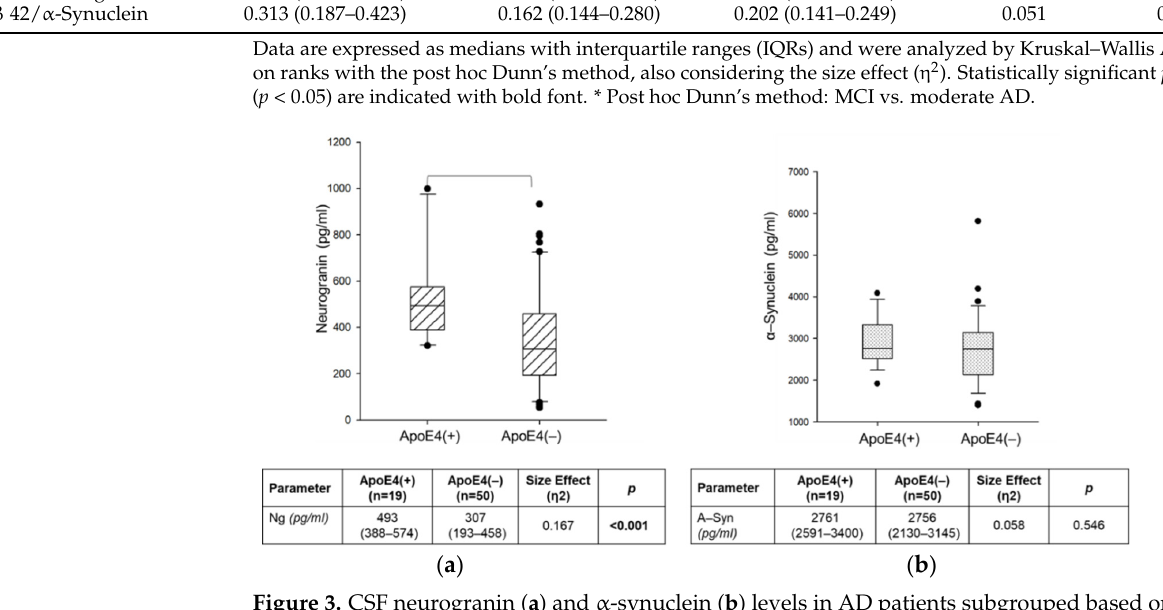
Figure 3. CSF neurogranin ( a ) and α -synuclein ( b ) levels in AD patients subgrouped based on ApoE ε 4 genotypes: ApoE4(+) and ApoE4( − ). Data are expressed as medians with interquartile ranges (IQRs) and were analyzed by the Mann–Whitney U test, also indicating the size effect ( η 2). p -values were corrected for multiplicity by the Holm–Sidak method and are indicated with bold font.